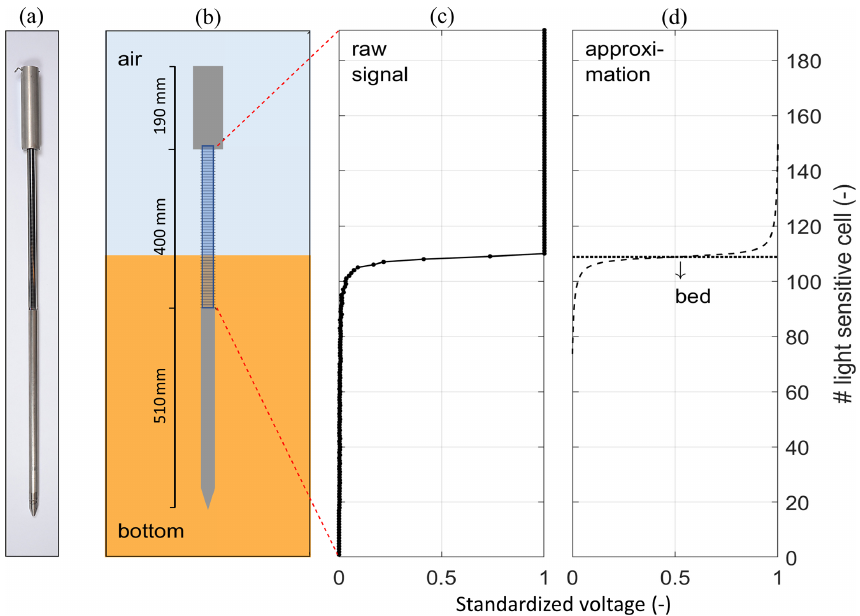
Figure 2. A photo (a) and schematization (b) of an SED sensor in operation. The sensor uses an array of light-sensitive cells to determine the position of the bed level, resulting in a transection in the raw voltage output of the array (c) . The noise in the raw signal is reduced, and the bed level is obtained by approximating the signal by an autonomous script (d) . Details of SED sensor data processing are included in Willemsen et al.